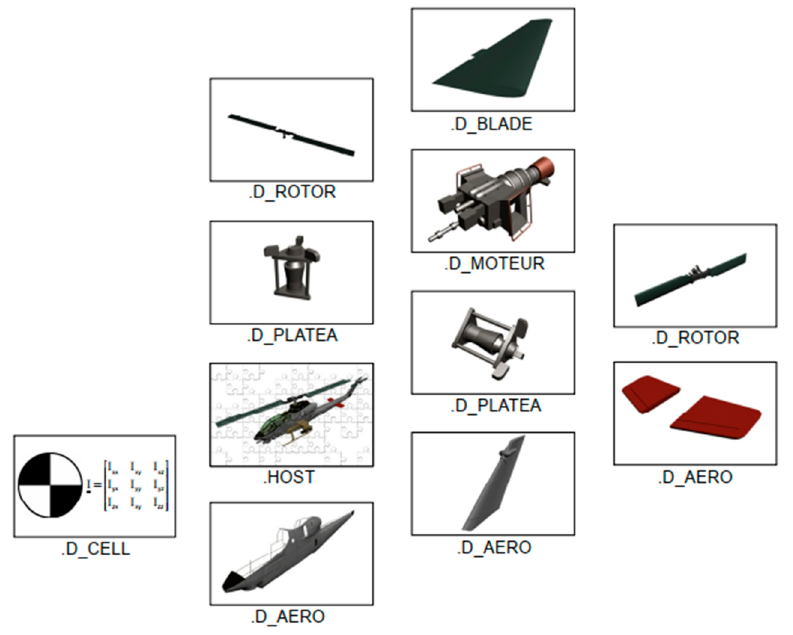
Figure 10. Simulation model components for a conventional main/tail rotor helicopter configuration.